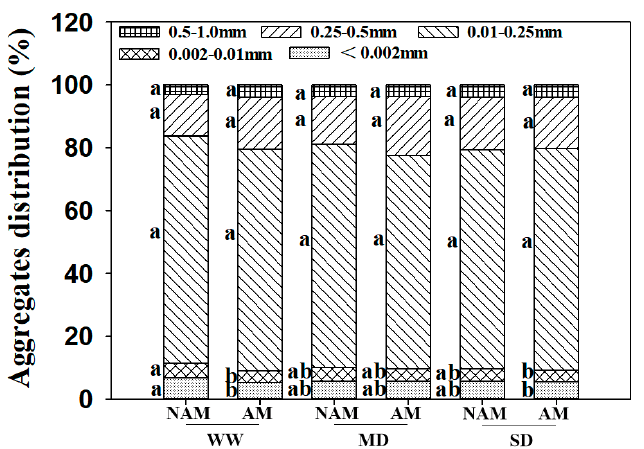
Figure 10. Effect of the arbuscular mycorrhizal fungus (AMF) Rhizophagus intraradices on the Figure 10. E ff ect of the arbuscular mycorrhizal fungus (AMF) Rhizophagus intraradices on the distribution distribution of soil aggregates under drought stress. NAM, non-AMF-inoculated; AM, of soil aggregates under drought stress. NAM, non-AMF-inoculated; AM, AMF-inoculated; WW, well-watered; MD, moderate drought; SD, severe drought. Di ff erent lowercase letters above the bars AMF-inoculated; WW, well-watered; MD, moderate drought; SD, severe drought. Different indicate significant di ff erences ( p < 0.05) among treatments. Values are means ± SE ( n = lowercase letters above the bars indicate significant differences ( p < 0.05) among treatments. Values are means ± SE ( n = 5).